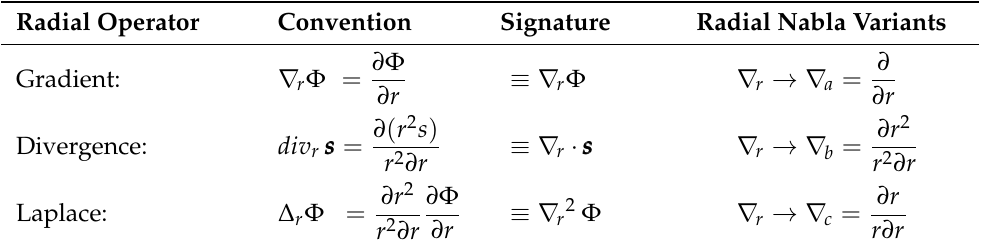
Table 2. Acc. to their signature the conventional radial operators gradient, divergence and Laplace lead to different radial Nabla variants ∇ a , ∇ b and ∇ c . Nabla variant ∇ c is taken as hypothesis.